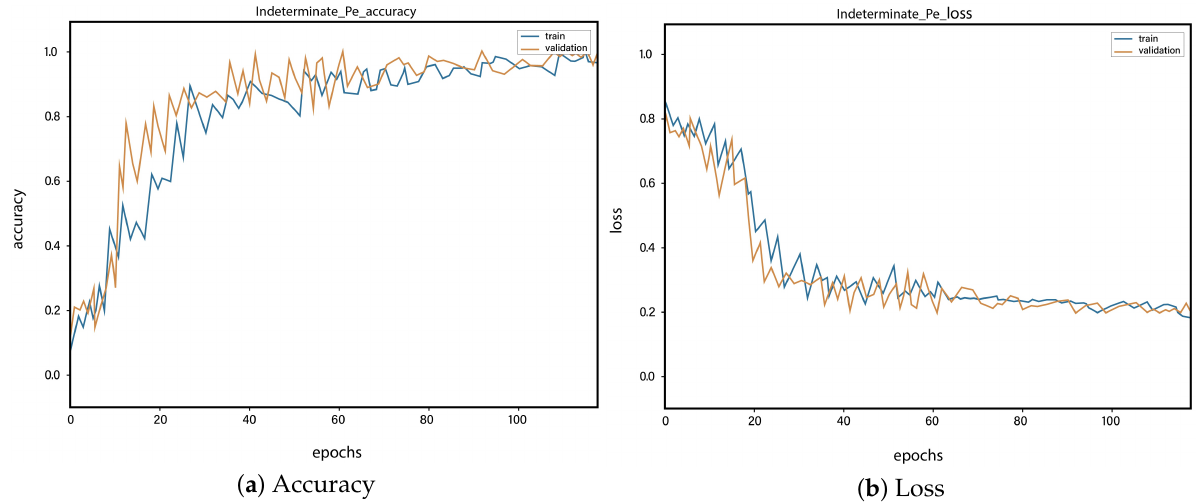
Figure 11. Training vs. validation accuracy and loss for the class: Acute and chronic PE.